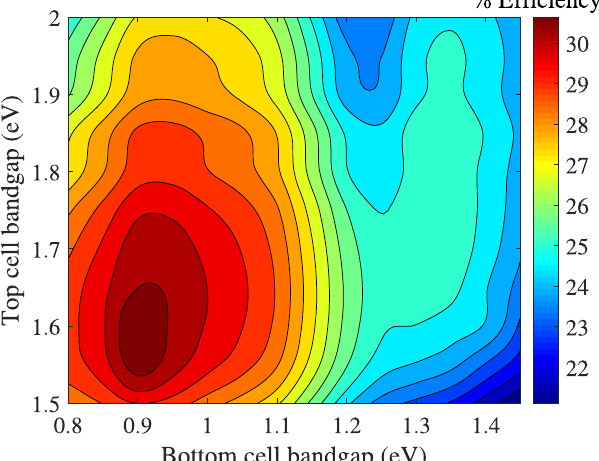
Fig. 9. 4T tandem solar cell ef fi ciency for different thicknesses of top and bottom cells, with top and bottom cell bandgaps fi xed at 1.82 eV and 1.20 eV, respectively. Trap-assisted recombination losses have not been considered.